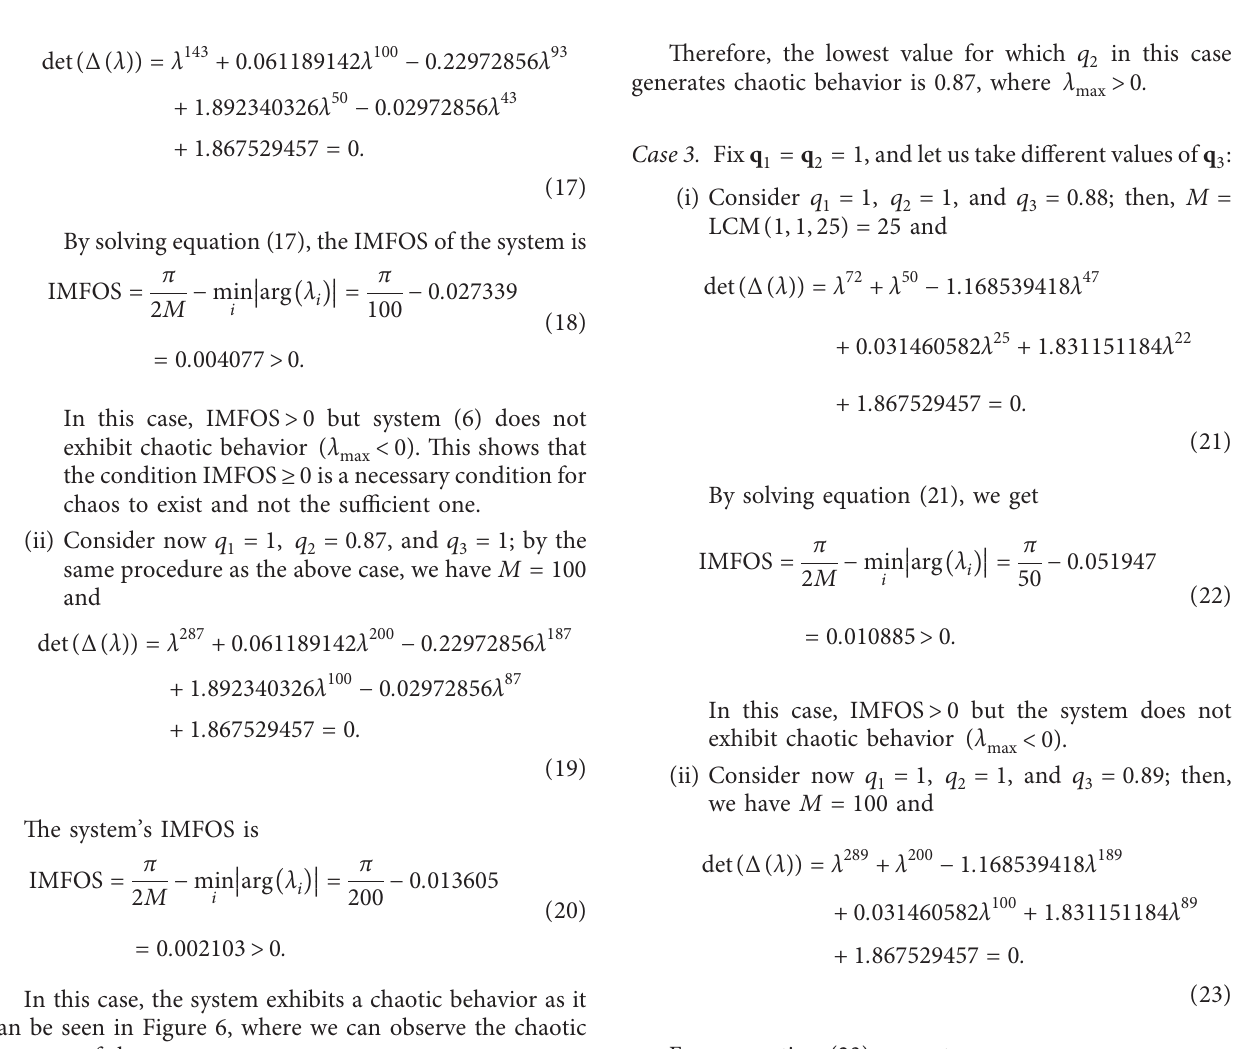
Figure 5: Phase diagrams of system (6) with fractional orders q x − z phase